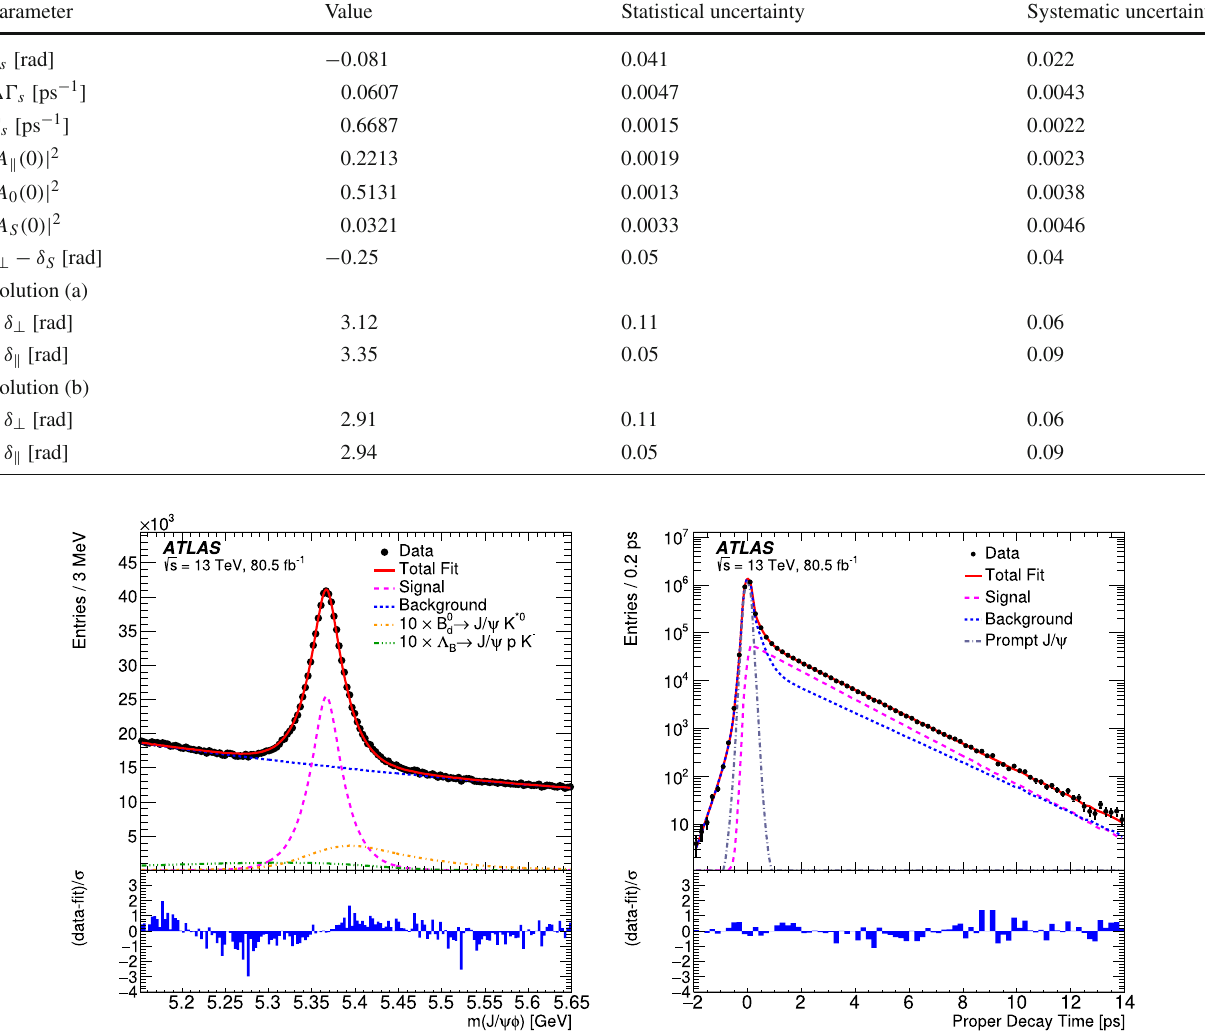
fit while the short-dashed magenta line shows the total signal. The total background is shown as a blue dotted line, and a long-dashed grey line shows the prompt J /ψ background component. Below each figure is a ratio plot that shows the difference between each data point and the total fit line divided by the statistical and systematic uncertainties summed in quadrature ( σ ) of that